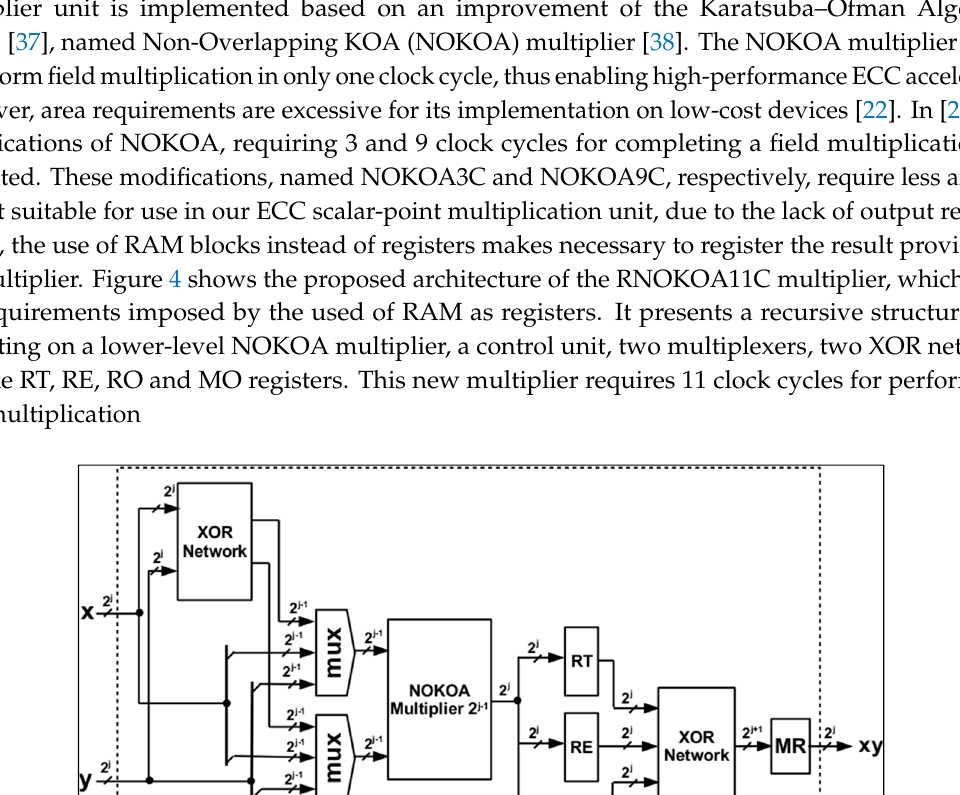
Table 1. Synthesis results for NOKOA9C and RNOKOA11C over GF(2 233 ) on Virtex 5 devices. Design